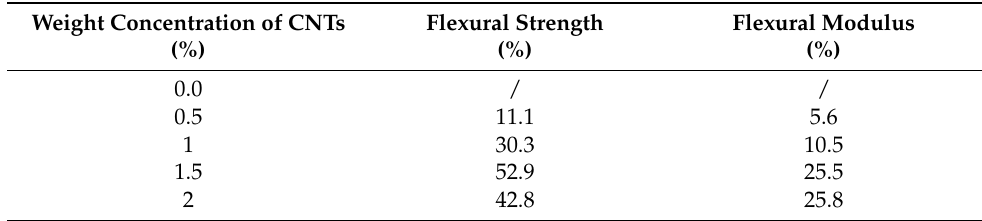
Figure 6. Dependence of flexural properties of epoxy/CNT nanocomposites on the weight concentration of CNTs of ( a ) flexural strength and ( b ) flexural modulus. Table 1. Increase percentage of flexural strength and modulus of epoxy/CNTs composites with the weight concentration of